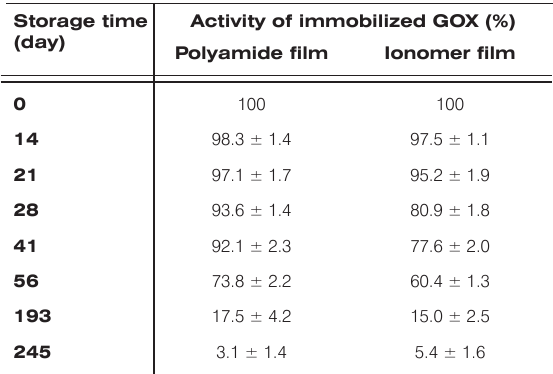
Table 3. Activity of GOX during the storage of prepared films at temperature of 4°C.